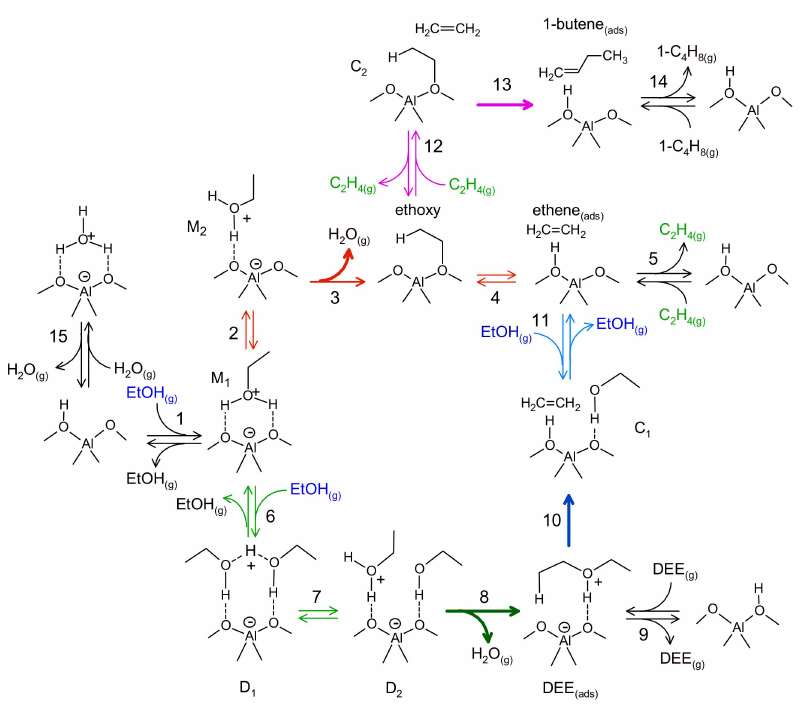
Figure 4. Reaction network used for the simulation of the industrial reactor (red: monomolecular dehydration, green: bimolecular dehydration, blue: di-ethyl ether decomposition, magenta: ethene dimerization). Modified from Alexopoulos et al.